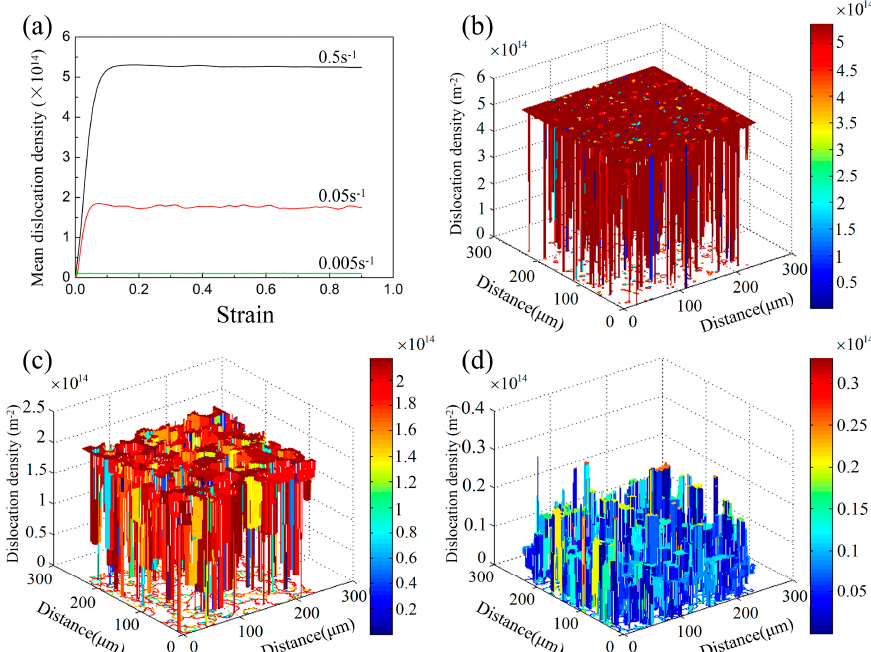
Figure 12. Dislocation density of FeMnSiCrNi SMA under DRX at the various strain rates at 1000 °C based on CA: ( a ) variation of dislocation density with strain; ( b ) ε = 0.9, 0.5 s − 1 ; ( c ) ε = 0.9, 0.05 s − 1 ; ( d ) ε = 0.9, 0.005 s − 1